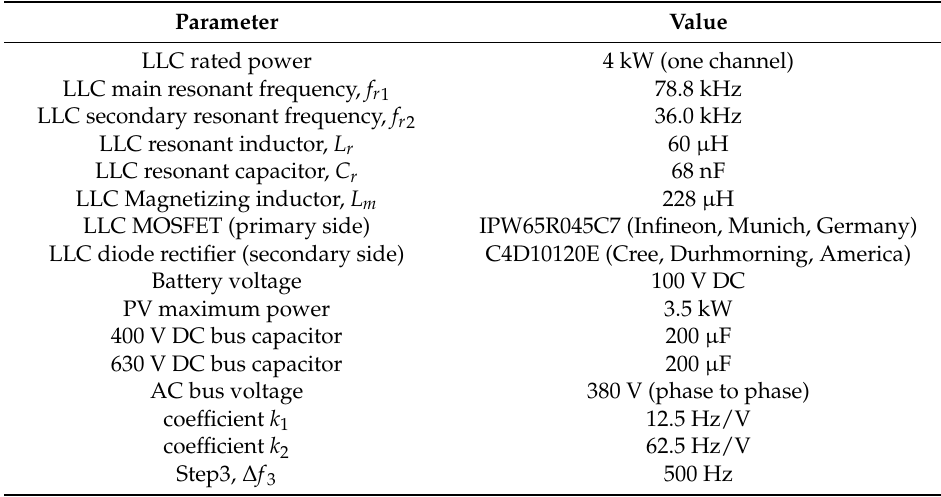
Table 2. Experimental parameters.